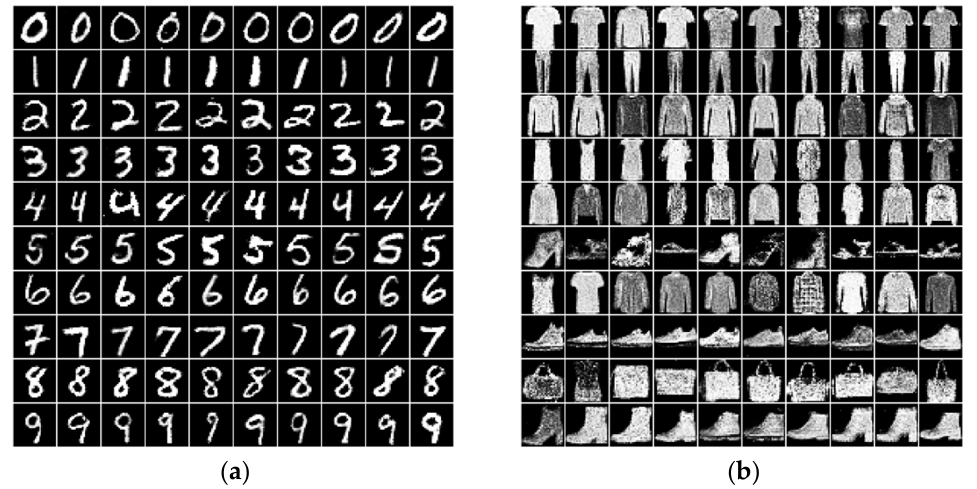
Figure 6. Samples generated by SGAN. ( a ) MNIST. ( b ) Fashion-MNIST.